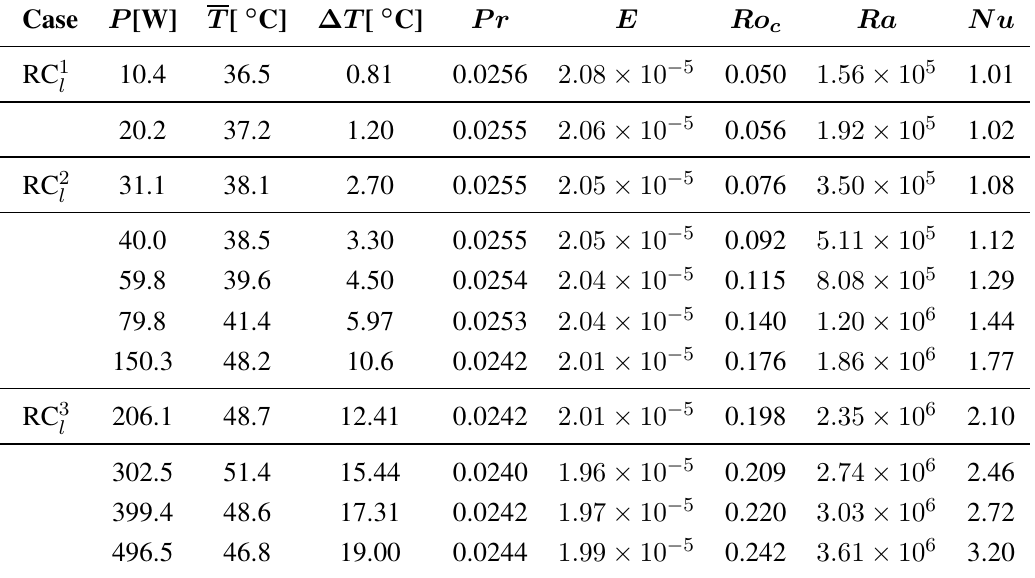
Table 7. Input and output parameters for Γ = 1 . 87 laboratory rotating convection (RC) experiments. The rotation rate of the table is fixed in all these cases 8 revolutions per minute; i.e. , the angular velocity Ω = 0 . 84 rad/s and the rotation period P the layer is fixed at H = 10 cm. (The Γ (cid:39) 1 data shown in Figure 15 is from [20].)